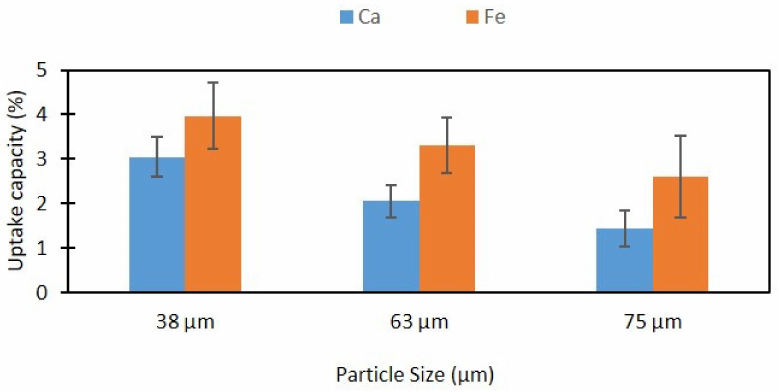
Figure 8. Average uptake capacity (%) for different particle size fractions of Fe-rich mine waste. Error bars represent standard error of the mean